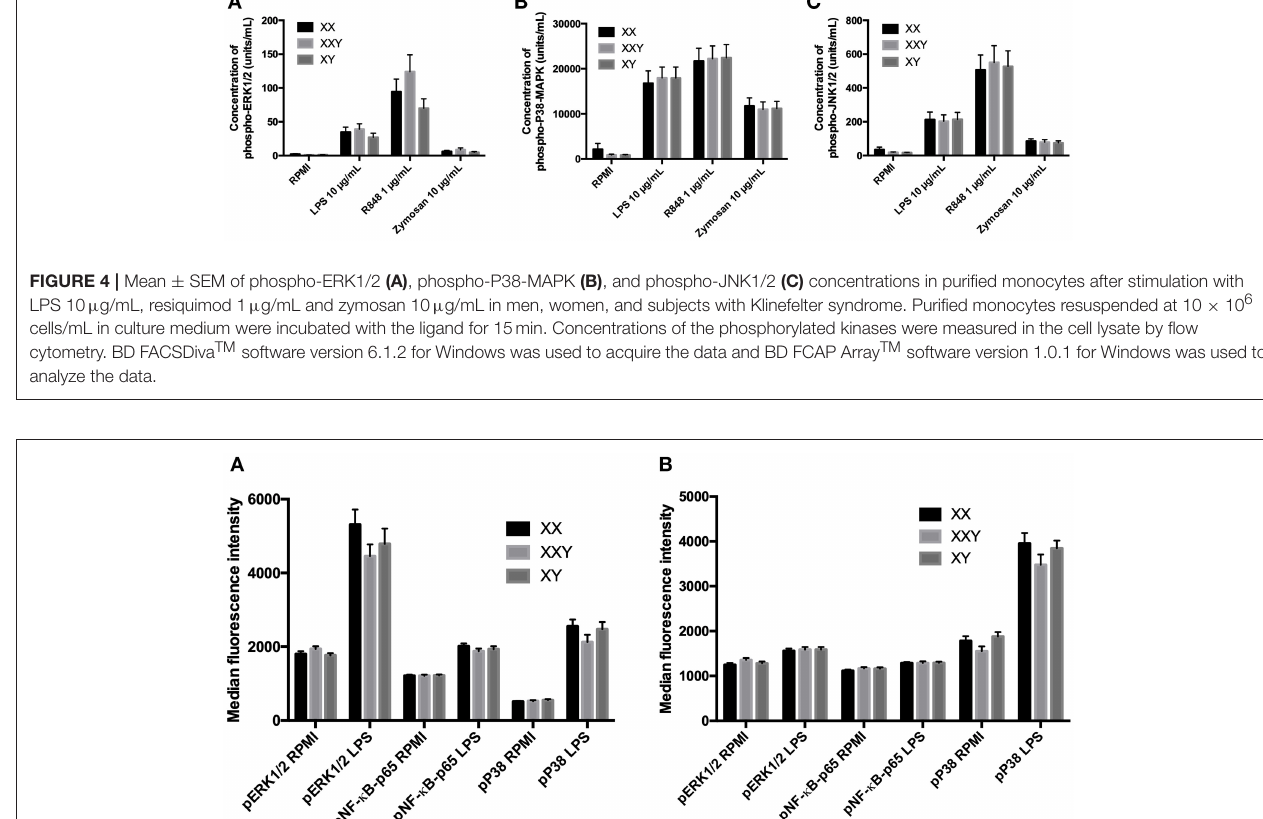
Frontiers in Immunology |